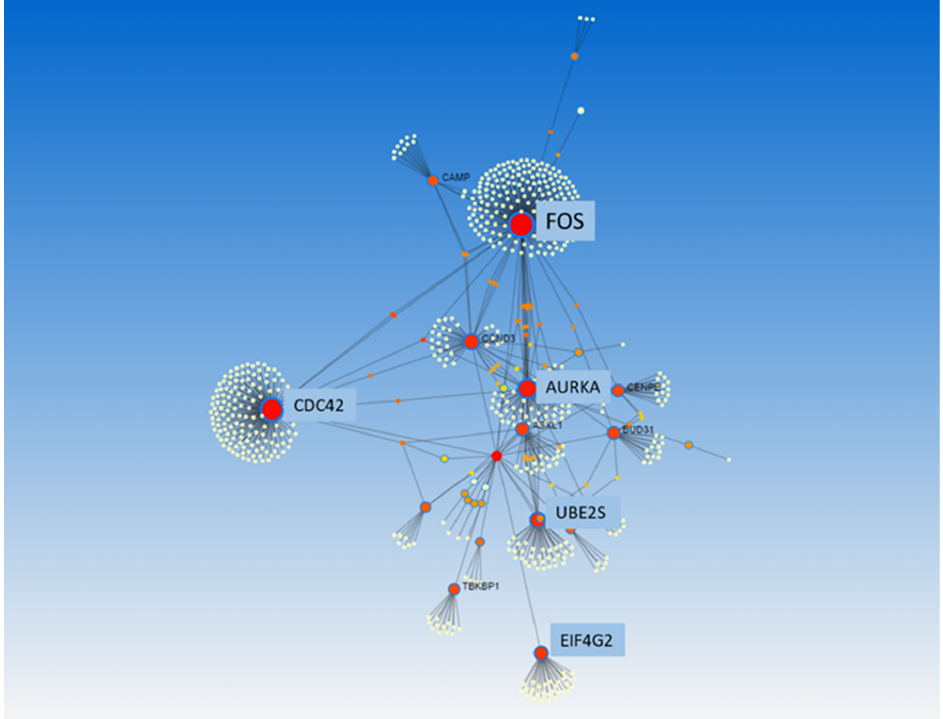
Figure 4. Protein–protein interaction analysis, from NetworkAnalyst 3.0, of transcriptional differences in whole blood associated with mortality in community-acquired pneumonia. All differentially expressed genes were used to perform this analysis. Table 3. Gene set enrichment analysis of transcriptional differences in whole blood associated with mortality in commu- nity-acquired pneumonia.